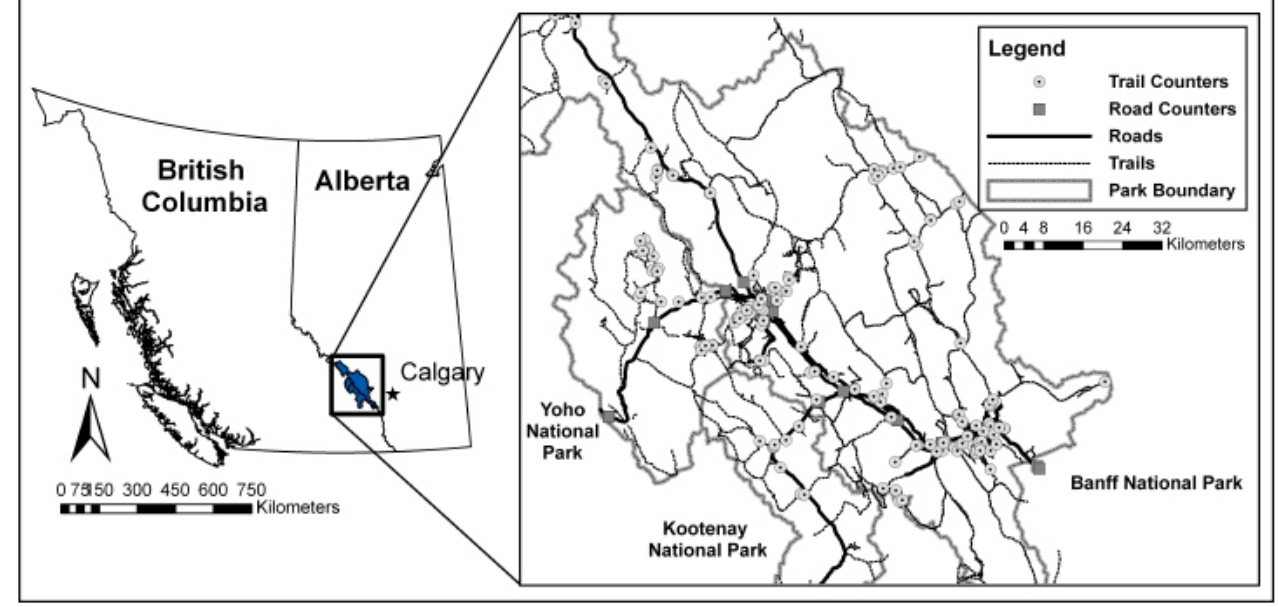
Fig. 1 . Location of study area: Banff, Kootenay, and Yoho National Parks within the provinces of British Columbia and Alberta,